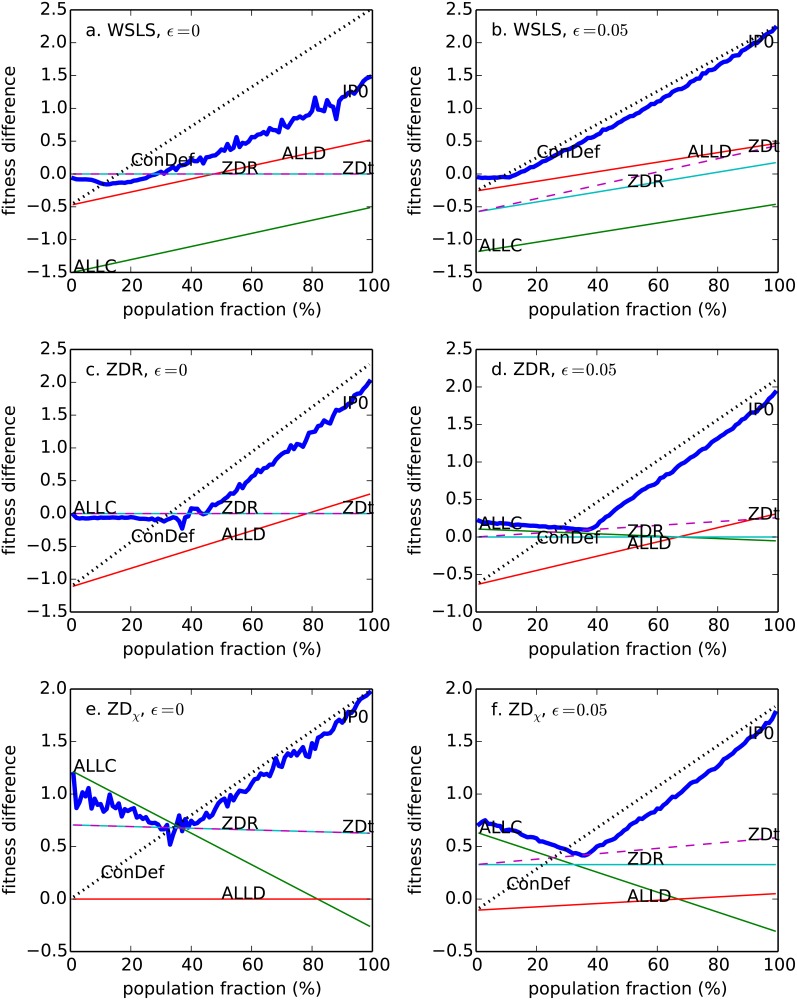
Mean fitness difference SI¯−SG¯ as a function of the invader’s population fraction.Plotted for several different invading strategies (I = ALLC, ALLD,ZDR, ConDef, ZDt) vs. several different resident strategies: WSLS (A, B); ZDR (C, D); ZDχ (E, F).